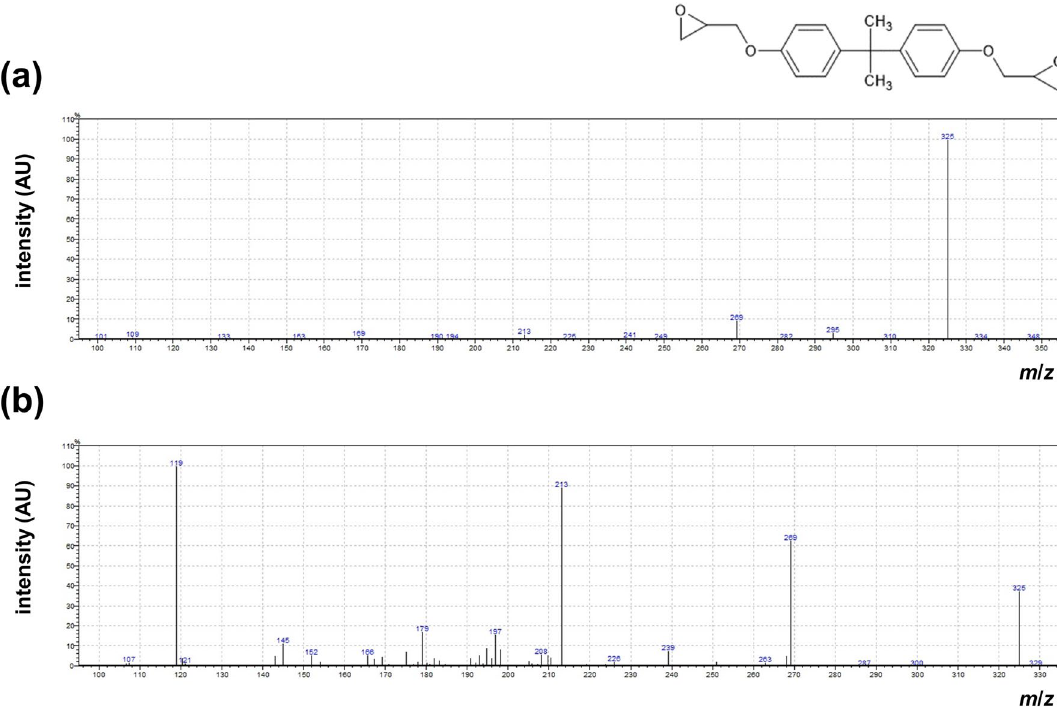
Figure 2. GC–MS/MS mass spectra of a migration solution from multilayer MEDI NOVA bags [molar mass: 340 g × mol −1 ( a ) and 325 g × mol −1 ( b